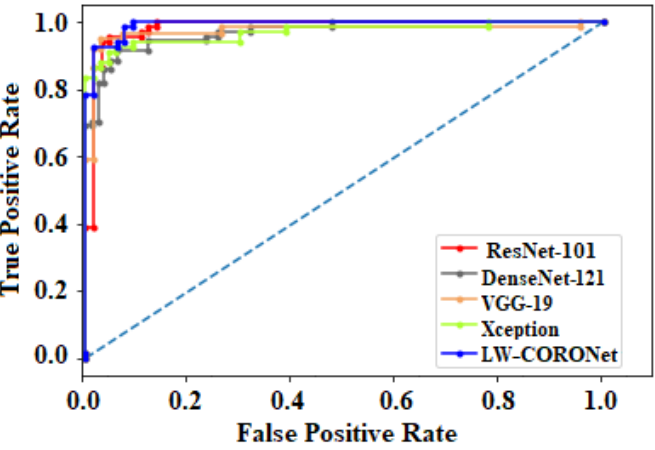
Figure 9. ROC curves of LW-CORONet and the pre-trained